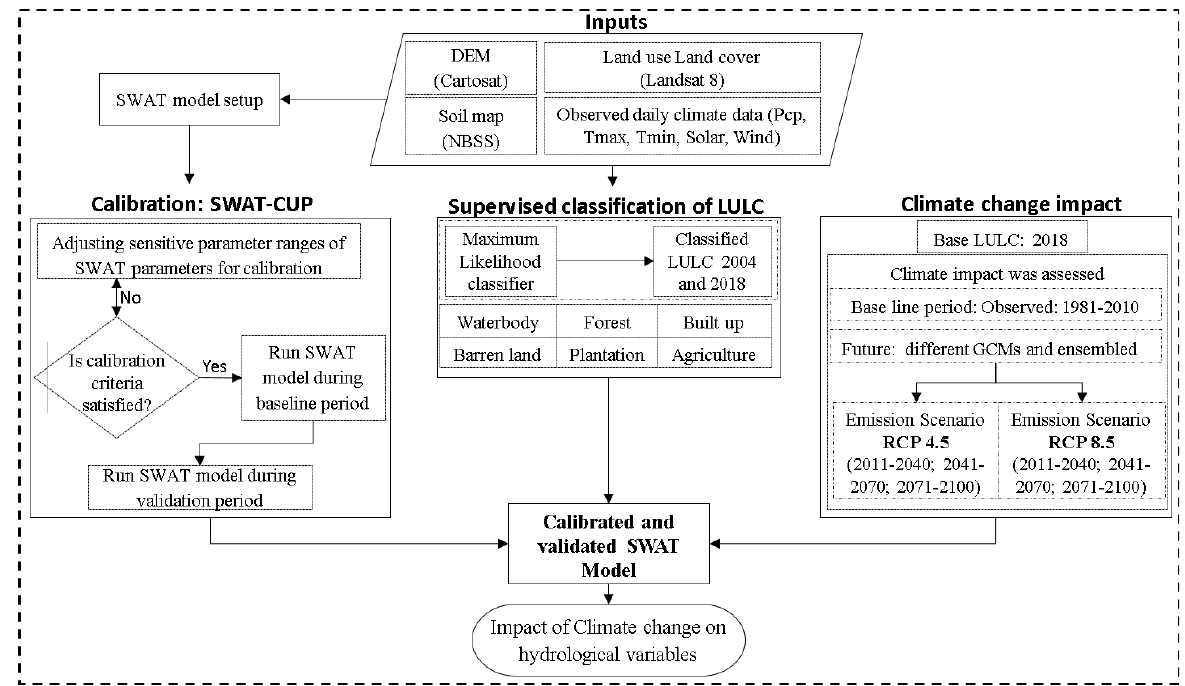
Figure 3. Schematic diagram of the research